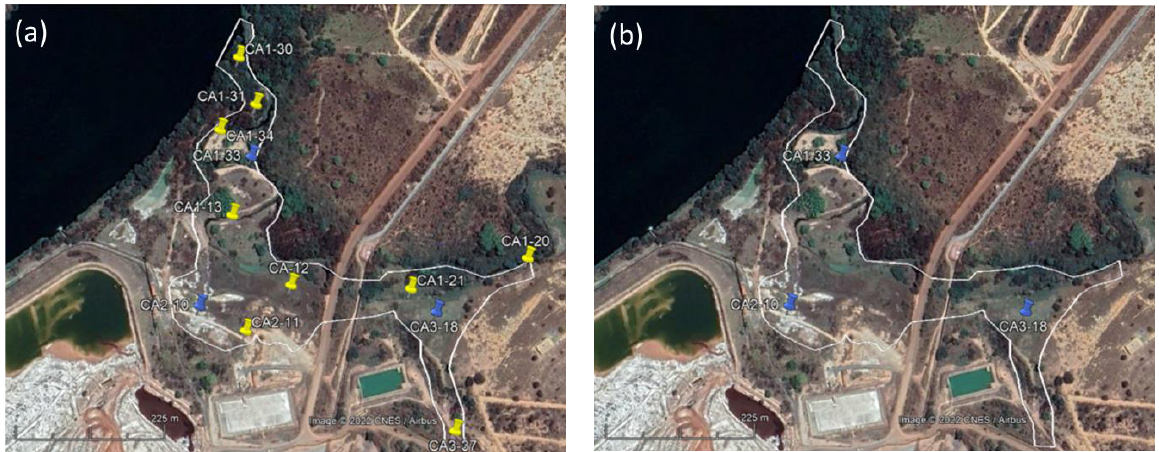
Figure 2. ( a ) Location of samples analyzed for geochemical characterization in the plant’s area of influence; ( b ) test samples’ location for zero-valent iron nanoparticles (nZVI) technology assess- ment.